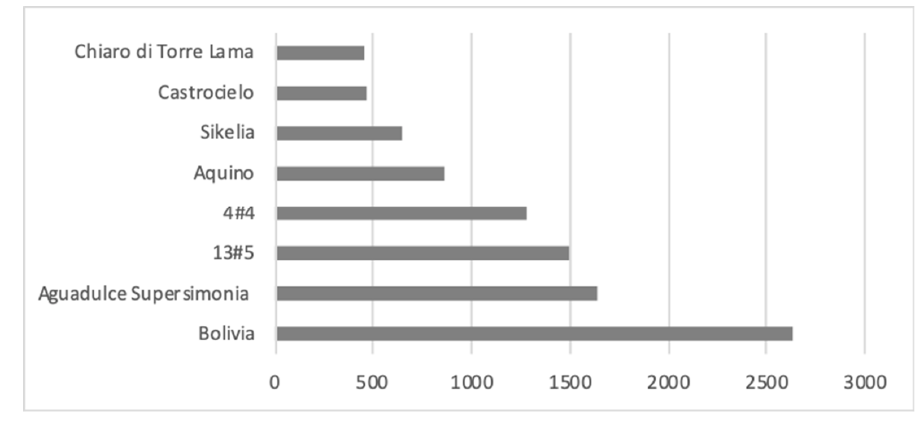
Figure 1. Weight of 1000 seeds of faba bean varieties (g).